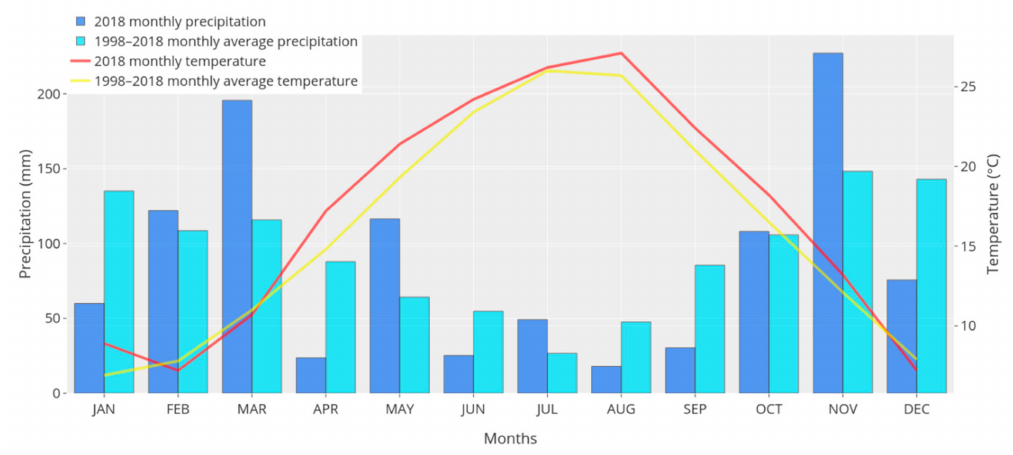
Figure 2. Monthly average precipitation and temperature between 1998 and 2018 and during the study year (2018). Data from the Ploˇce city meteorological station (43 ◦ 2 (cid:48) N, 17 ◦ 26 (cid:48) E, 2 m a.s.l.). The meteorological station is located 2.9 km from the studied fig orchard.